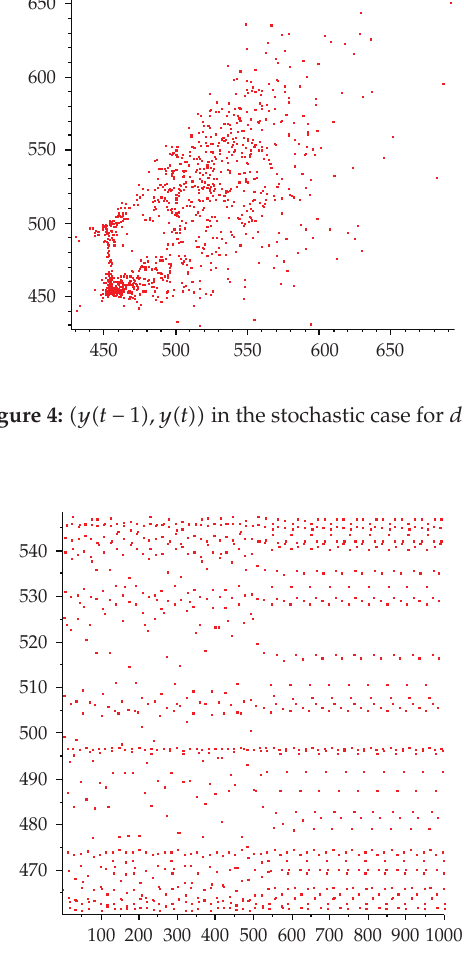
Figure 5: (cid:2) t,y (cid:2) t (cid:3)(cid:3) in the deterministic case for d (cid:7) 0 .